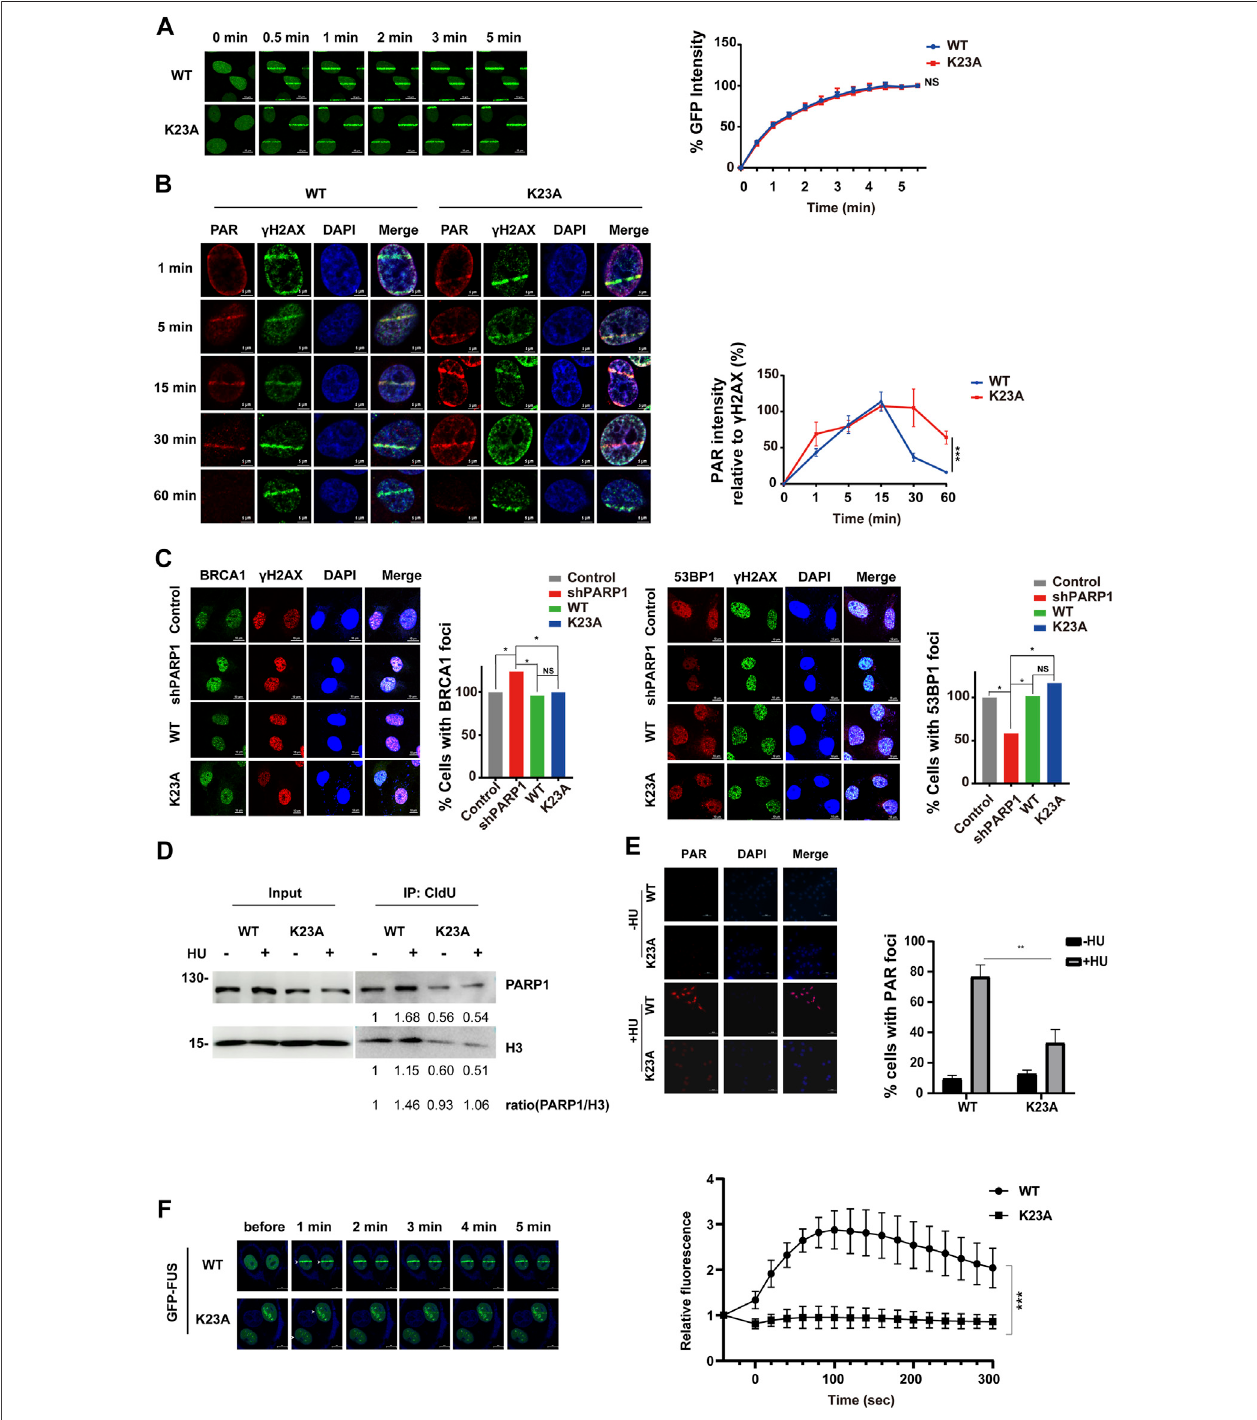
FIGURE 5 | PARP1 K23 mono-methylation is essential for the cell response to replication fork stress. (A) Translocation kinetics of PARP1 to DNA damage sites upon UV laser microirradiation. U2OS cells overexpressing EGFP-PARP1 WT or K23A were subjected to laser microirradiation to generate DSBs in a line pattern. The relocationkineticsofEGFP-PARP1toDSBsweremonitoredoveratimecourseasindicated.GFPintensitiesatthelaserlinewerenormalizedintoanumericalvalueusing Nikon NIS-Elements AR software (version 4.40.00). Normalized fl uorescence curves from 10 cells were averaged. The error bars represent SD. (B) PAR formation at DNA damage sites upon UV laser microirradiation. U2OS cells overexpressing HA-tagged WT or K23A PARP1 were subjected to laser microirradiation to generate DSBs in a line pattern. The kinetics of the PAR polymer at DSBs were monitored over a time course as indicated. PAR immuno fl uorescence intensities at the laser line were normalized into a numerical value, and PAR laser intensity relative to γ H2AX was calculated using Nikon NIS-Elements AR software (version 4.40.00).